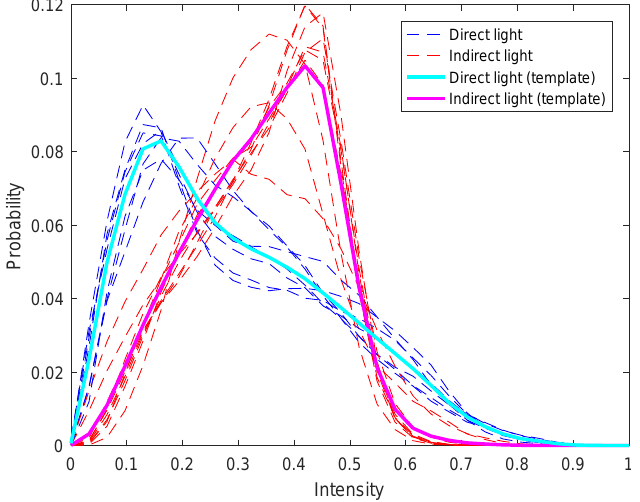
Figure 6. Example of illumination histograms using 32 bins and a factor of 8 downscaling of the images. Example of histograms of images from the test set for the two illuminations using the selected settings (bin size of 32 and a factor of 8 downsampling of the images), as well as the corresponding templates generated from the training